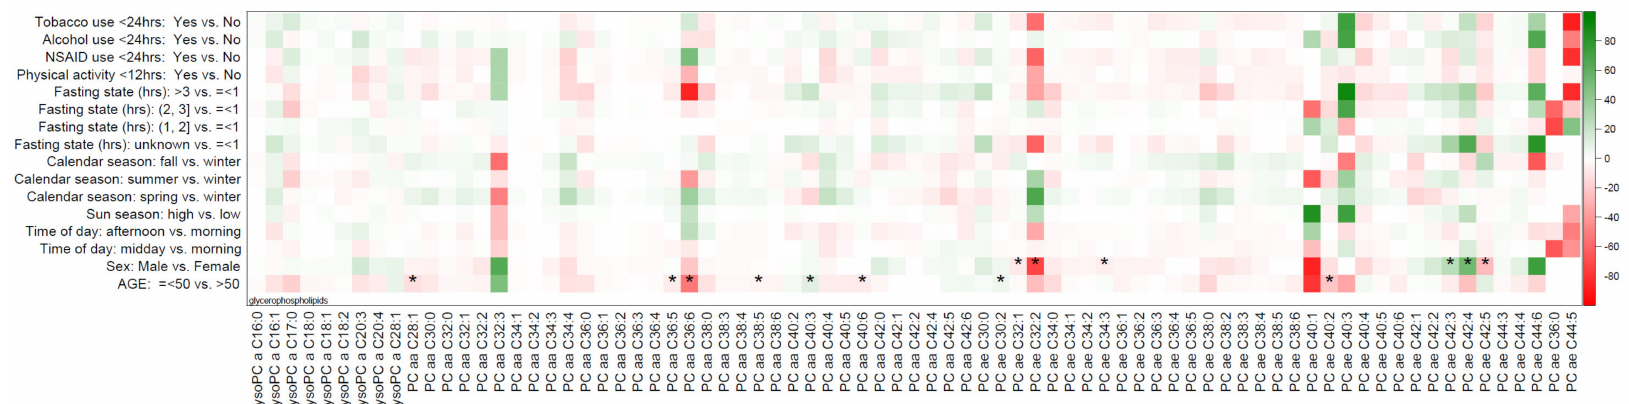
Figure 1. Heatmap of percentage di ff erence in mean metabolite concentrations of glycerophospholipids across categories of pre-blood collection factors in the PRÄVENT cohort ( n = 108). Statistically significant (adjusted for age and sex) findings based on FDR correction indicated with an “*”.